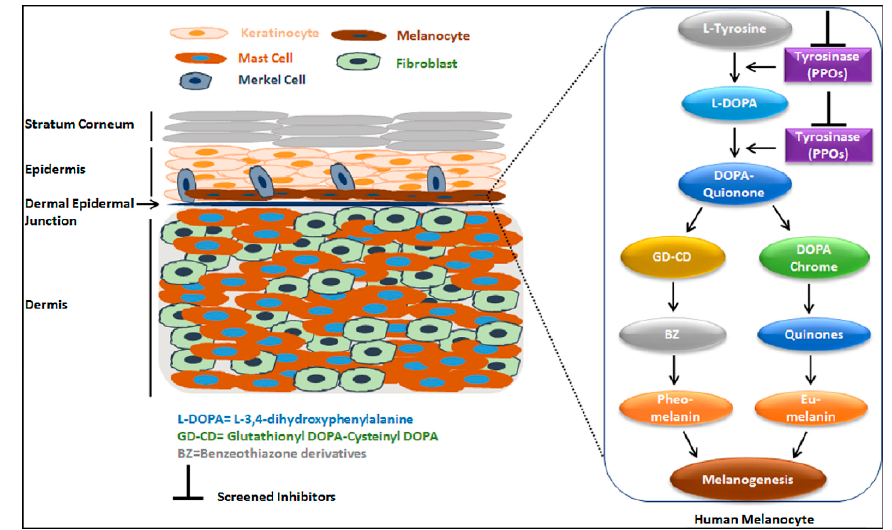
Figure 1. The basic mechanistic pathway of melanin in the melanogenesis [28]. The biological effects of hormones on human melanocytes are still being investi- gated [30]. There are multiple hormones that have mitogenic and/or melanogenic